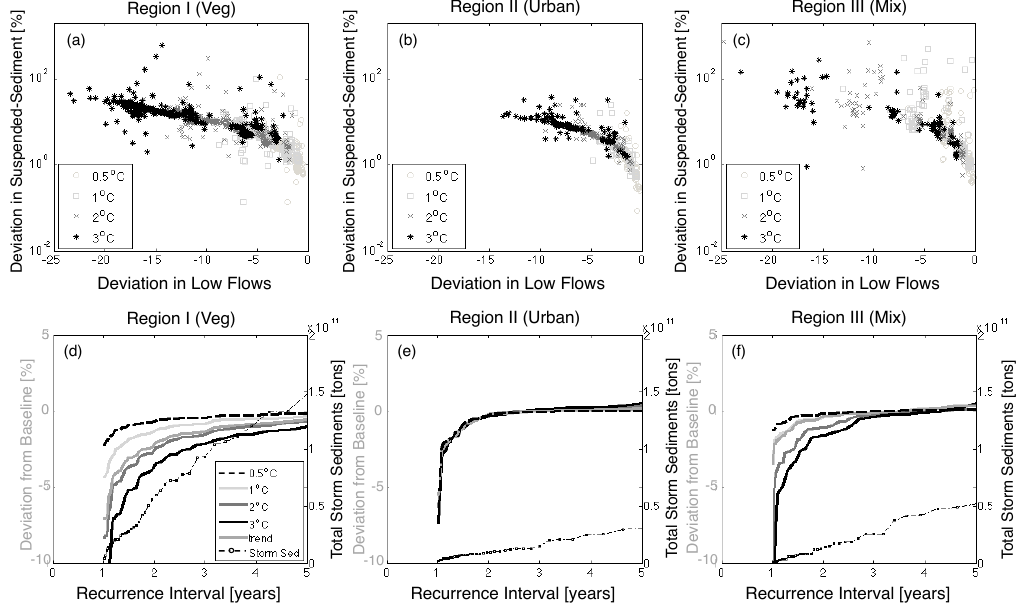
Fig. 7. Percent deviation in daily suspended sediment versus percent deviation in daily low-flow (a–c) and recurrence interval of annual storm sediments due temperature increase during low flow (d–f) . Low flow corresponds to 90% probability of exceedance.